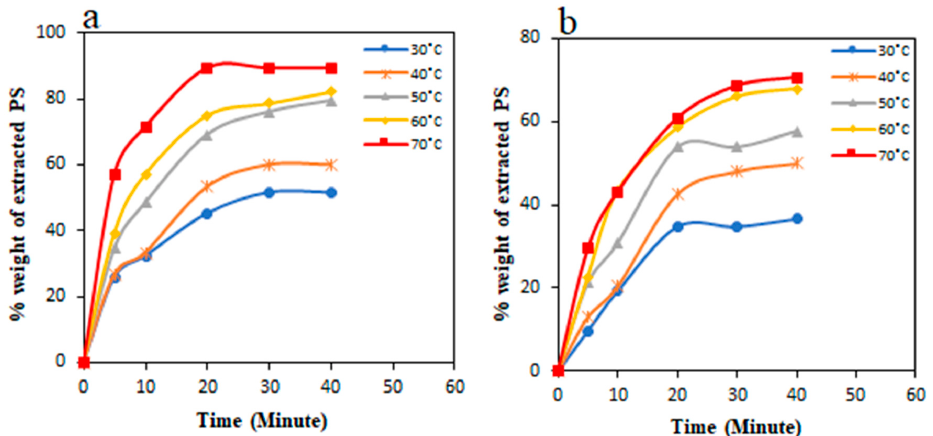
Figure 12. Mass loss of PS binder during solvent debinding from the micro-parts of ( a ) SS 17-4PH; and ( b ) 3YSZ.